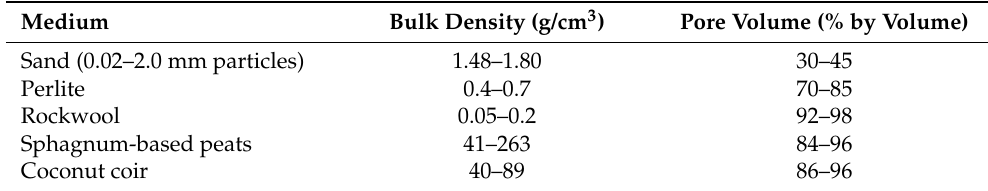
Table 1. Typical physical characteristics of common inorganic and organic hydroponic growing media